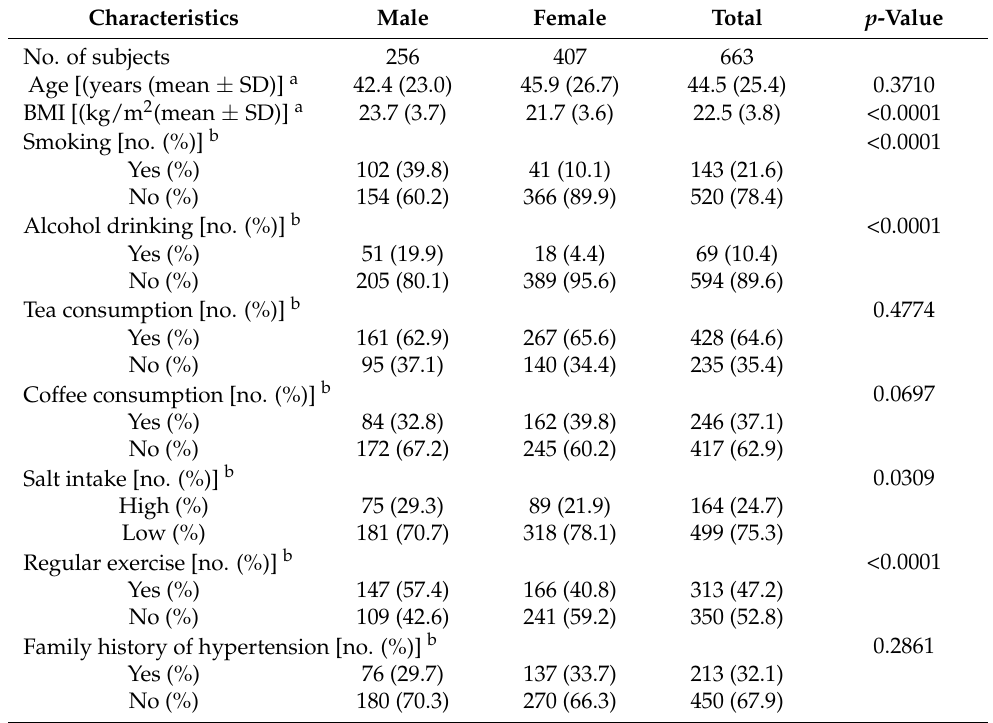
Table 1. Demographic characteristics of participants.